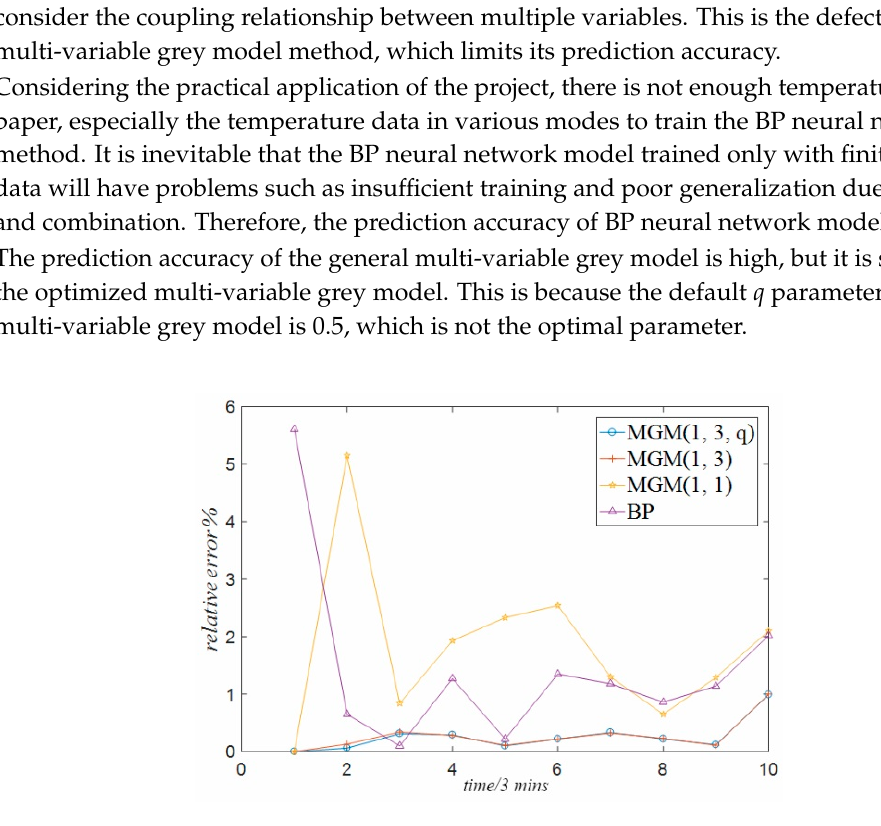
Figure 7. Relative error of guide bearing .